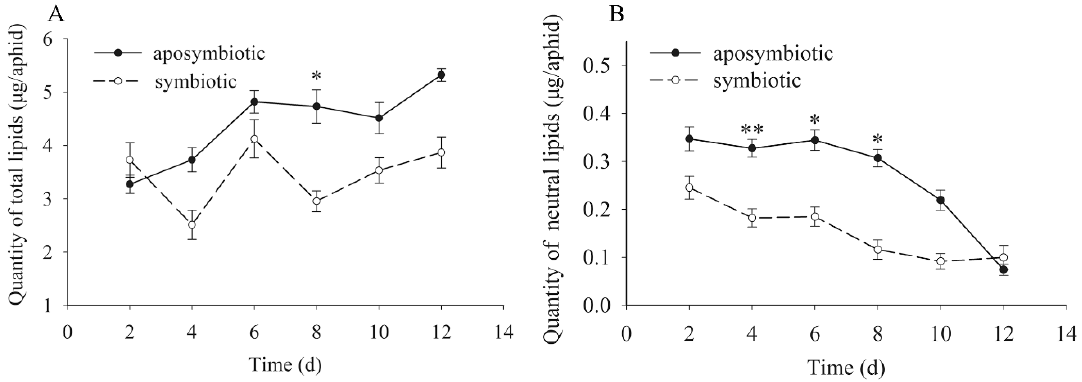
Figure 4. Dynamic changes of total lipids and neutral fats in pea aphids that were Buchnera absent or infected. Black dot: rifampicin-treated aphid; Clear circle: healthy control aphid. The star “*” means significant differences between the antibiotic-treated and control aphids, the double star “**” means significant differences between the antibiotic-treated and control aphids at 0.01. The black dot or clear circle with error bars were the mean ± standard error. ( A ) Dynamic changes of total lipids ( t = 3.113, df = 16, p = 0.011 on day 8). ( B ) Dynamic changes of neutral fats ( t = 3.373, df = 16, p < 0.01 on day 4; t = 2.539, df = 16, p = 0.029 on day 6; t = 2.278, df = 16, p = 0.046 on day 8).